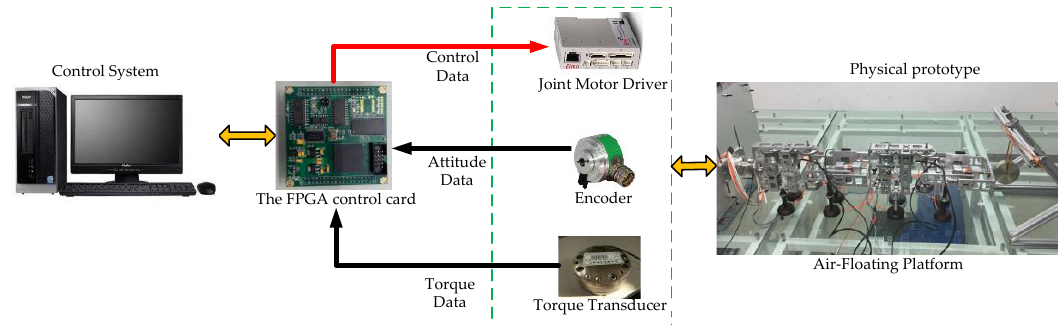
Figure 9. The diagram of the experimental system.